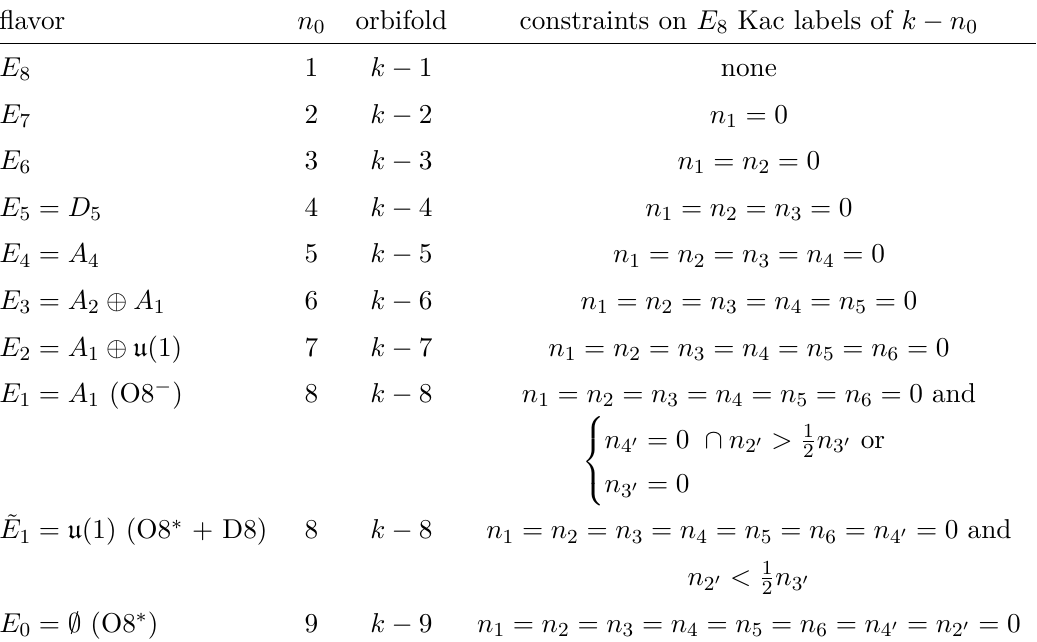
-string theories with k 1+(8 − n 0 ) = 1 case of the massive E -string even though the labels themselves are 0 8 = N . ˜ E has an extra D8 on top of the O8 ∗ ; E does 0 1 0 contain those for E as a subcase, which is to be expected 1 0